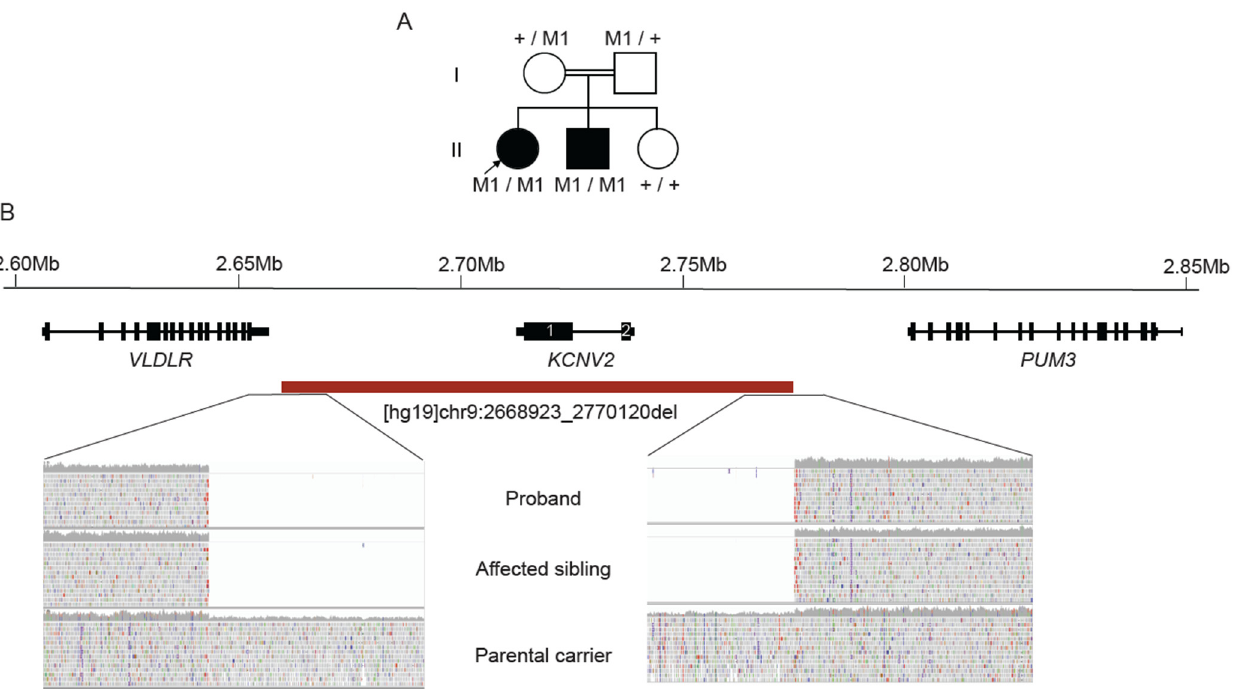
Figure 4. Homozygous deletion identified involving KCNV2 . ( A ) Pedigree of family with two sib- lings with cone dystrophy, suggestive of autosomal recessive inheritance. M1 = KCNV2 heterozy- gous deletion allele, + = wild type allele; ( B ) Location of the genomic deletion identified by WGS including IGV screenshots of reads spanning the 5 ′ and 3 ′ breakpoints. Proband (II.1) [top] & af- fected sibling (II.2) [middle] showing no reads (homozygous deletion). Parental carrier (I.1) [bottom] showing reduced read depth (heterozygous deletion) compared to flanking adjacent genomic seg-